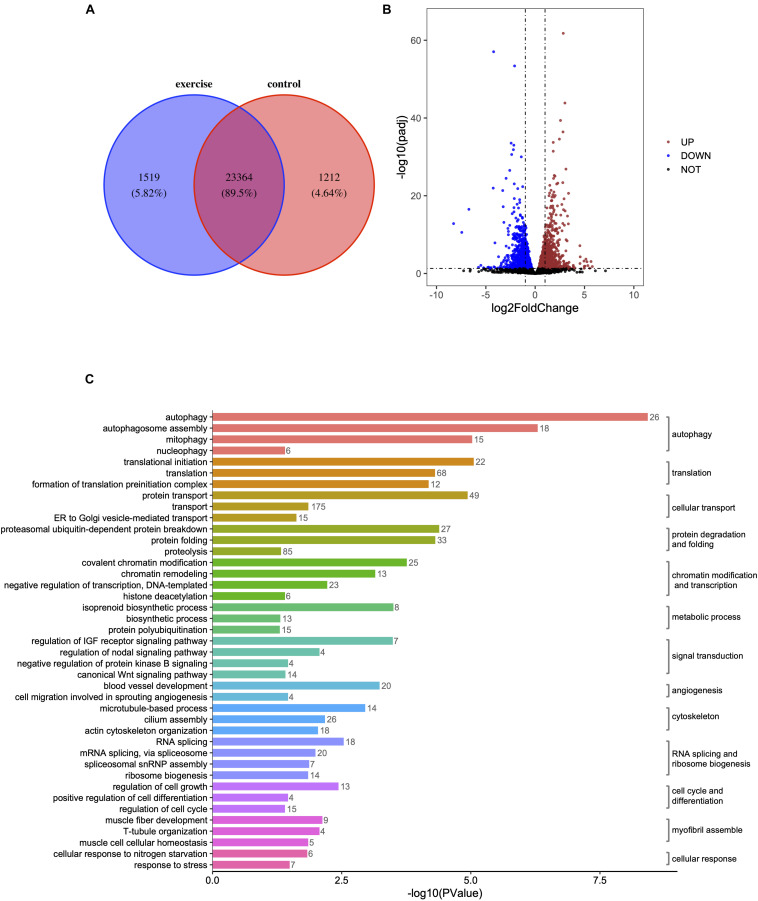
Identification of differentially expressed genes (DEGs) and enrichment analysis of GO terms in zebrafish hearts after excessive exercise and in the control group. (A) Venn diagram of the total number of identified genes in the excessive exercise and control groups. (B) Volcano plot constructed using fold-change values and P adj-values. Red: upregulated, Blue: downregulated. (C) The DEG enrichment analysis of GO terms in the biological process subcategory. The number indicates the number of DEGs that are enriched in the clustered representative terms.